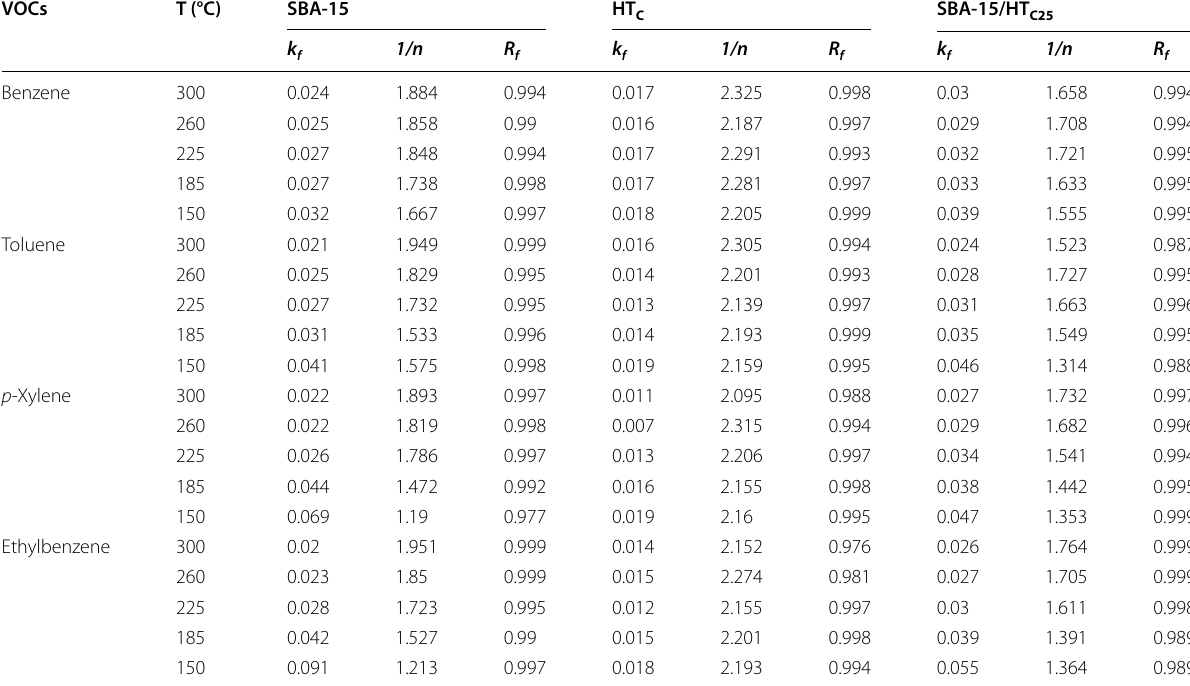
Table 4 Freundlich equation parameters for volatile organic compound (VOC) adsorption in SBA-15, HT HT